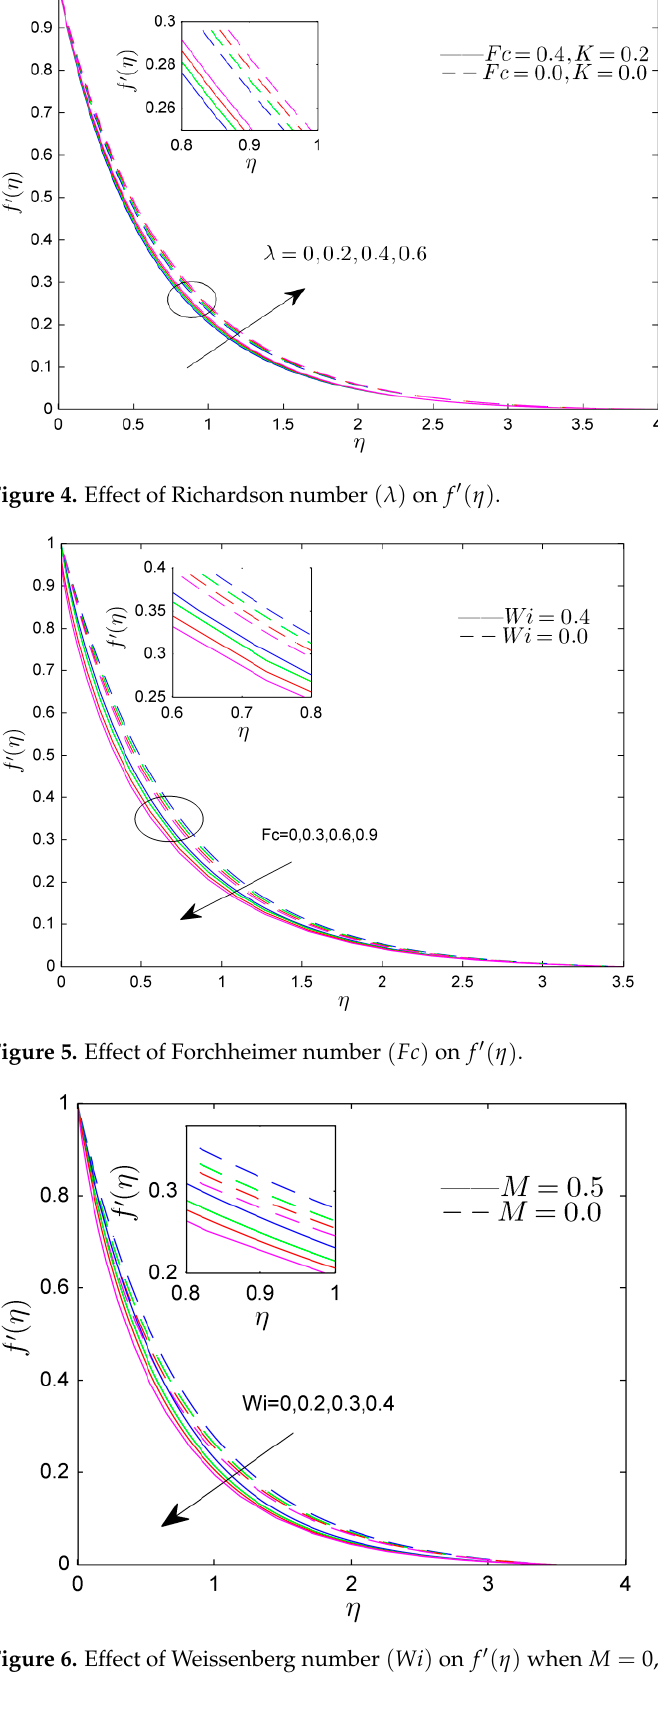
Figure 3. Effect of Suction/Injection parameter (𝑓𝑤) on 𝑓 (cid:4593) (𝜂) .